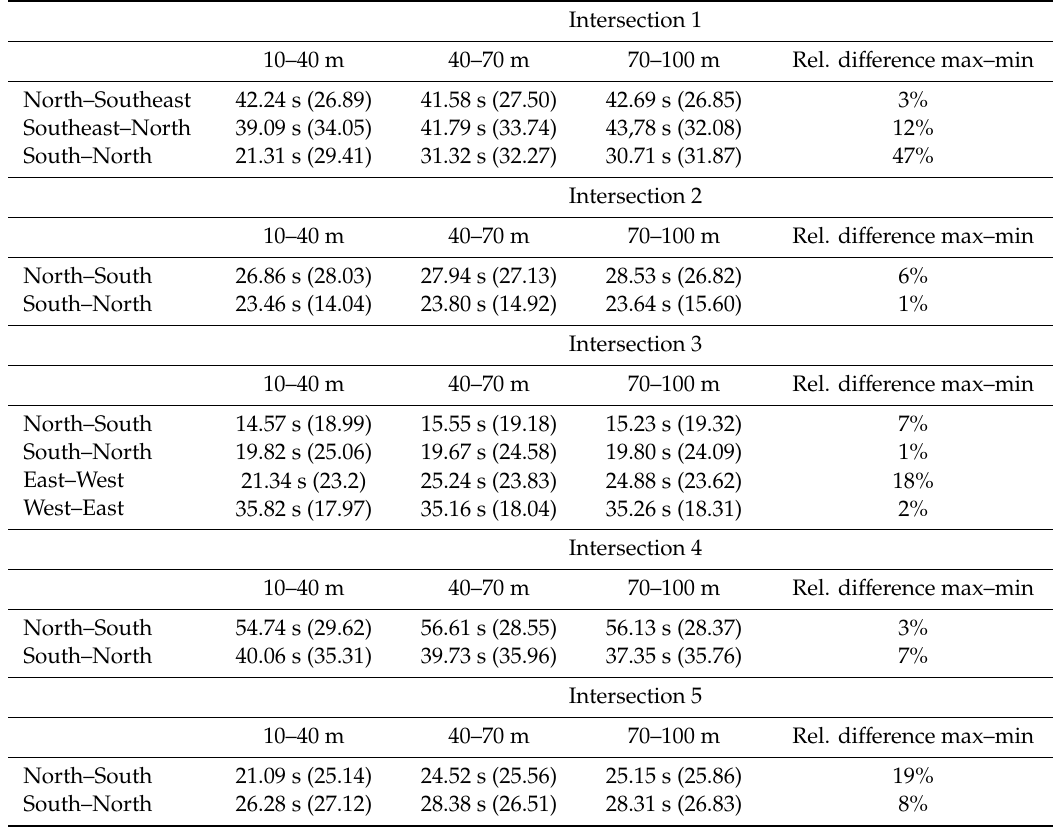
Table 2. Calculated average delays and standard deviations based on di ff erent selections of the first GPS (Global Positioning System) measurement.